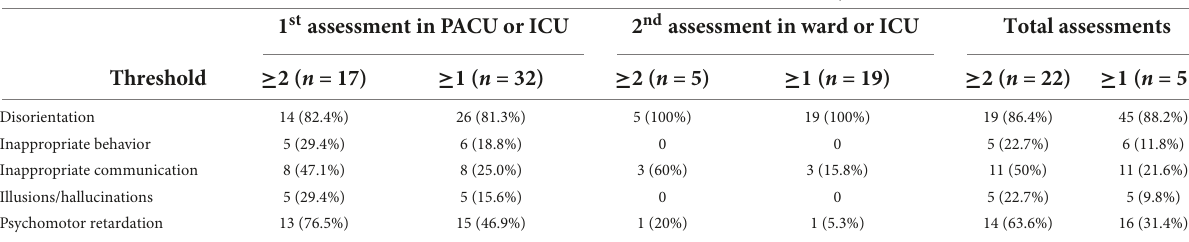
TABLE 2 Number and percentage of delirious patients categorized by each item of the Thai-version of the Nu-DESC. Items